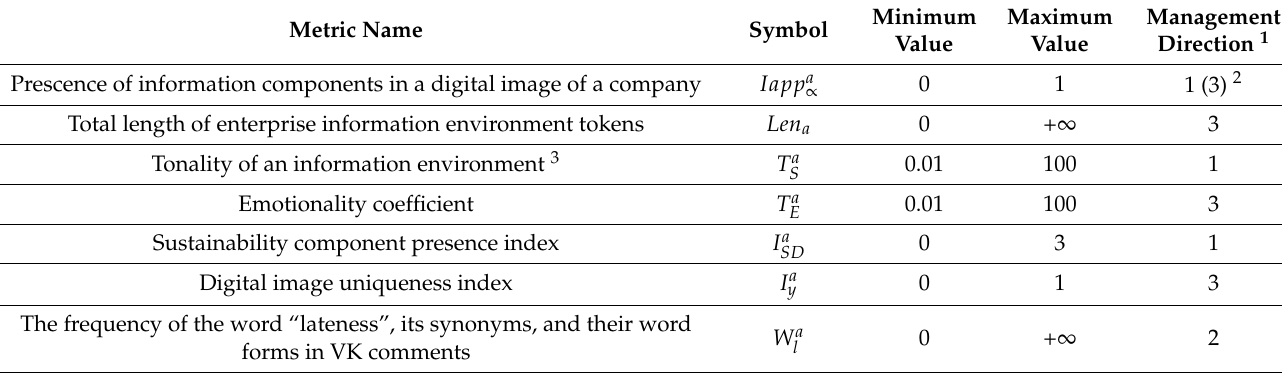
Table 3. Key metrics for company digital image